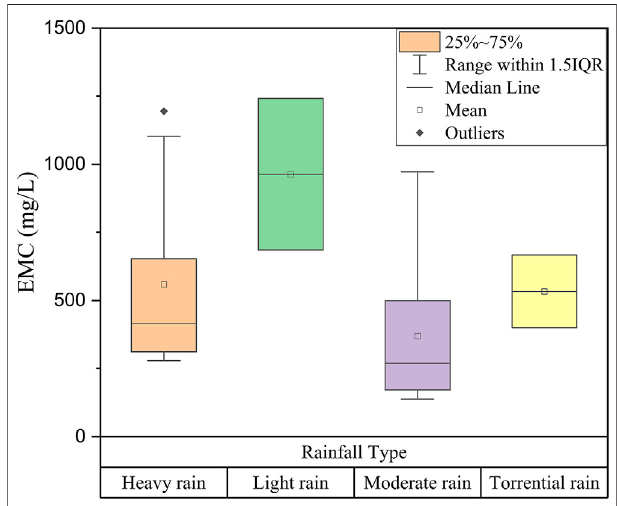
FIGURE 3 | EMC values under different rainfall